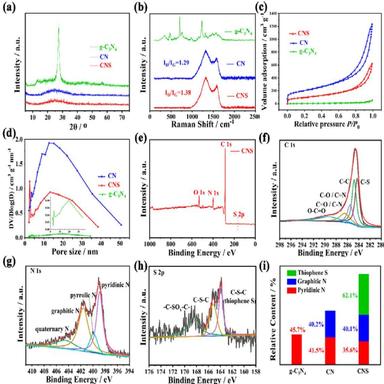
(a) XRD patterns, (b) Raman spectra, (c) nitrogen adsorption-desorption isotherms, and (d) pore size distribution curves of g-C3N4, CN, and CNS catalysts. Survey spectrum (e) and high-resolution XPS spectra of C 1s (f), N 1s (g), and S 2p (h) for CNS catalyst, respectively. (i) The fitted relative contents of thiophene S, graphitic N, and pyridinic N of g-C3N4, CN, and CNS catalysts. (A colour version of this figure can be viewed online.)